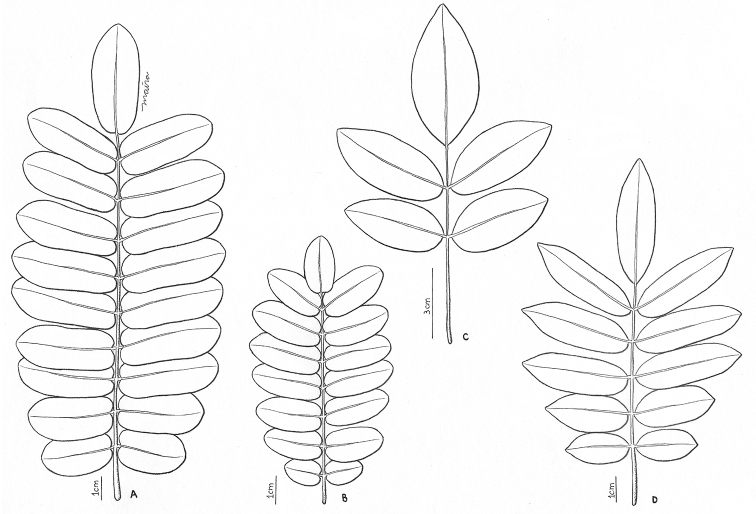
Leaves in Rourea
subgen.
R.
sect.
Multifoliolatae: AR.
discolorBR.
martianaCR.
tenuisDR.
cnestidifolia.